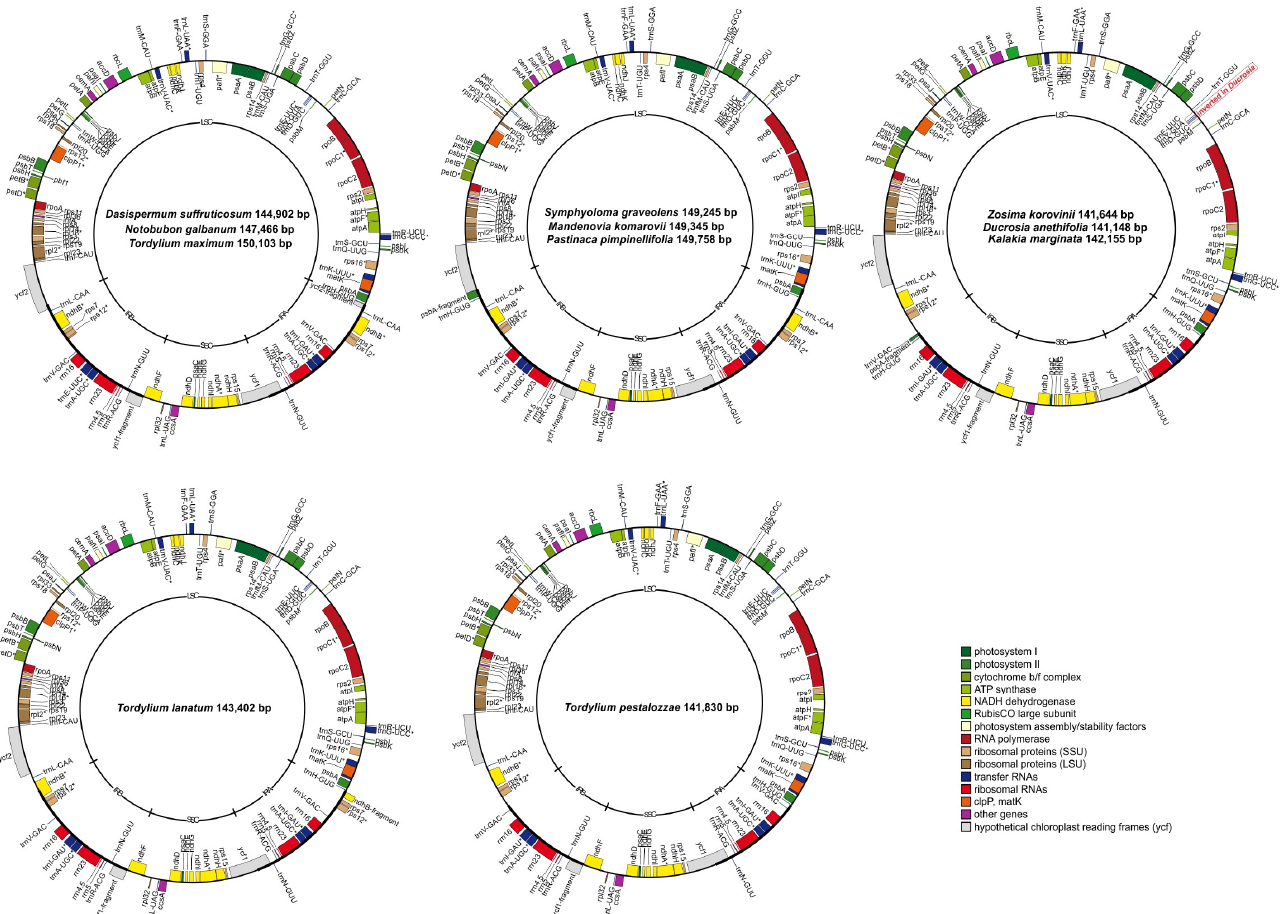
Figure 1. Circular gene maps of eleven plastid genomes of Tordylieae tribe representatives. Genes plotted outside the circle are transcribed counterclockwise, inside genes—clockwise. Genes are colored according to their function, intron-containing genes are marked with asterisks. LSC = large single-copy region, SSC = small single-copy region, IRA and IRB = inverted repeats A and B, respectively. The longest IRs belong to T. maximum with J LB in ycf2 ; J LB in D. suffruticosum ; and